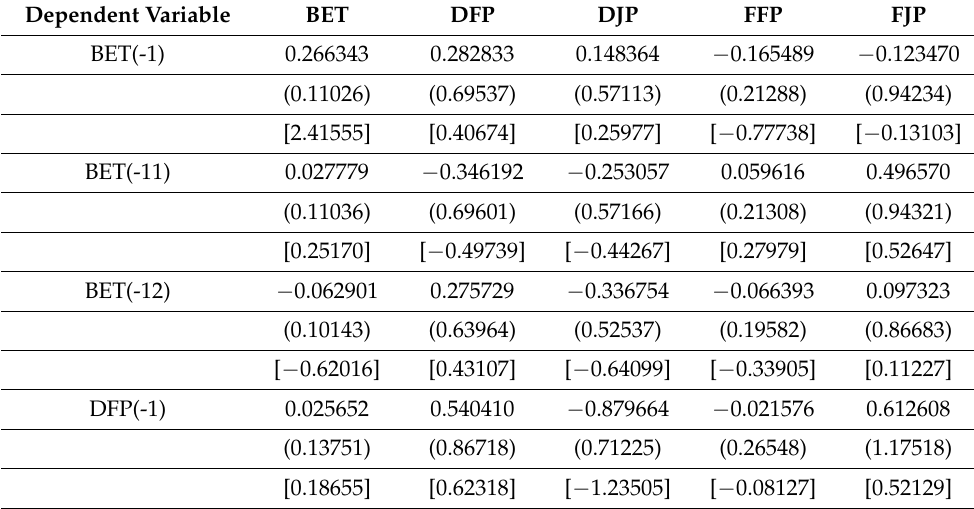
Table 7. VAR estimation